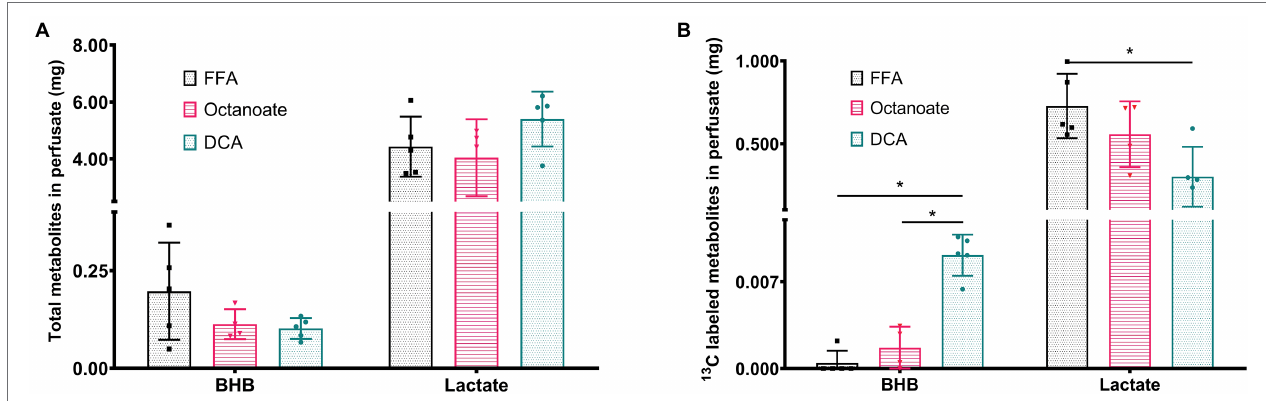
FIGURE 4 | (A) Total amount of BHB and Lactate from efferent perfusate post [2- 13 C] pyruvate injection in mg using GC-MS standard curve quantification. (B) Amount of 13 C labeled BHB and Lactate that are (total mg metabolites * total enrichment) in efferent perfusate post [2- 13 C] pyruvate injection. * Indicates statistical significance ( p < 0.05; see section Materials and Methods).